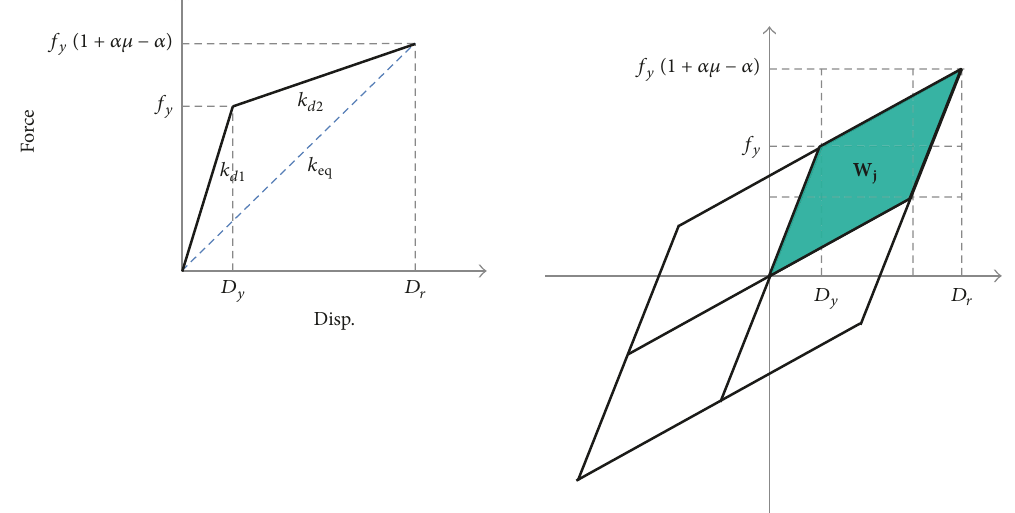
Figure 17: Bilinear idealization of the hysteretic curve of the MHD for small deformation.